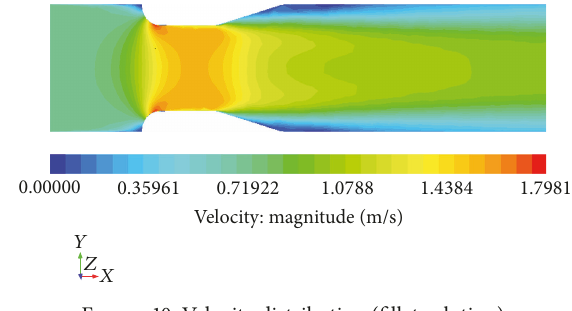
Figure 10: Velocity distribution (fillet solution).